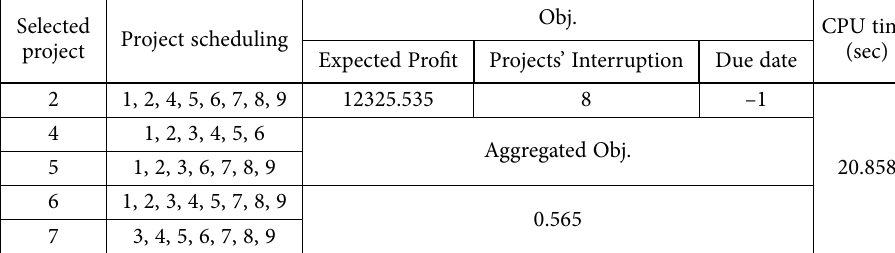
Table 5. The result of the fourth scenario Selected